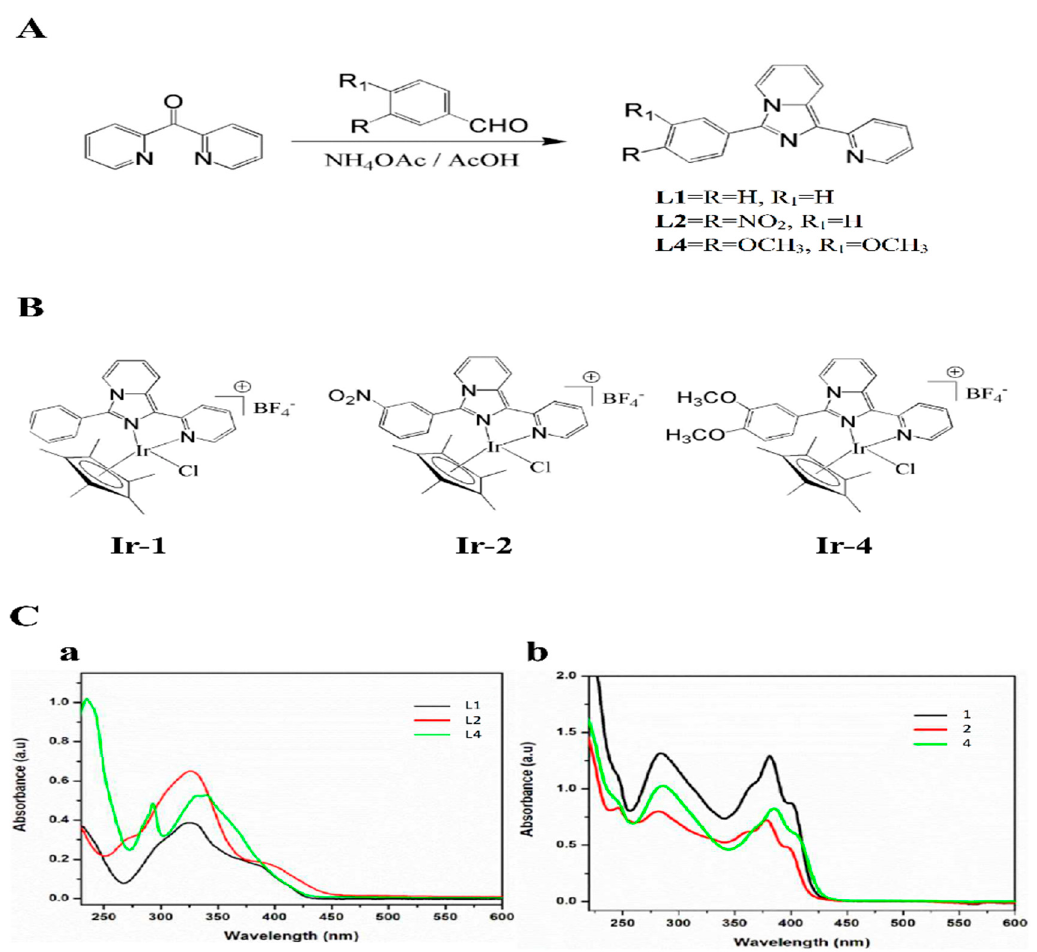
Figure 1. Synthesis of ligands and Ir-III complexes. ( A ) Scheme of synthesis of ligands 1-(2-pyridyl)- 3-phenylimidazo[1,5- α ]pyridine (L1), 1-(2-pyridyl)-3-(3-nitrophenyl)imidazo[1,5- α ]pyridine (L2) and 9-[4-(1-pyridin-2-yl-imidazo[1,5- α ]pyridin-3-yl)-phenyl]-9H-carbazole (L4); ( B ) Scheme of synthesis of complexes [Ir(Cp*)(L1)Cl]BF 4 (Ir-1), [Ir(Cp*)(L2)Cl]BF 4 (Ir-2) and [Ir(Cp*)(L4)Cl]BF 4 (Ir-4); ( C ) Absorption spectra of ligands ( a ) and Ir-III complexes ( b ) in acetonitrile.